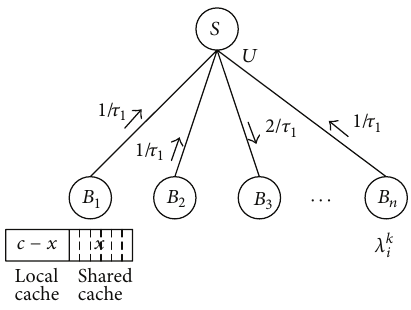
Figure 4: Indirect coordinated edge caching